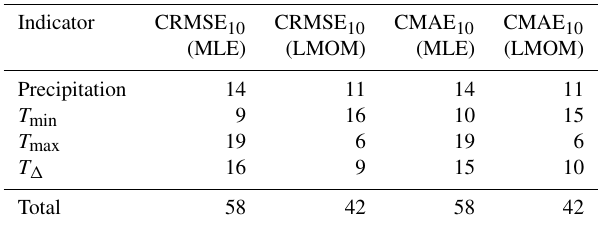
Table 4. Comparison of parameter estimation methods for the PDS approach based on conditional goodness-of-fit measures CRMSE 10 and CMAE 10 . Numbers indicate success cases of MLE and LMOM.